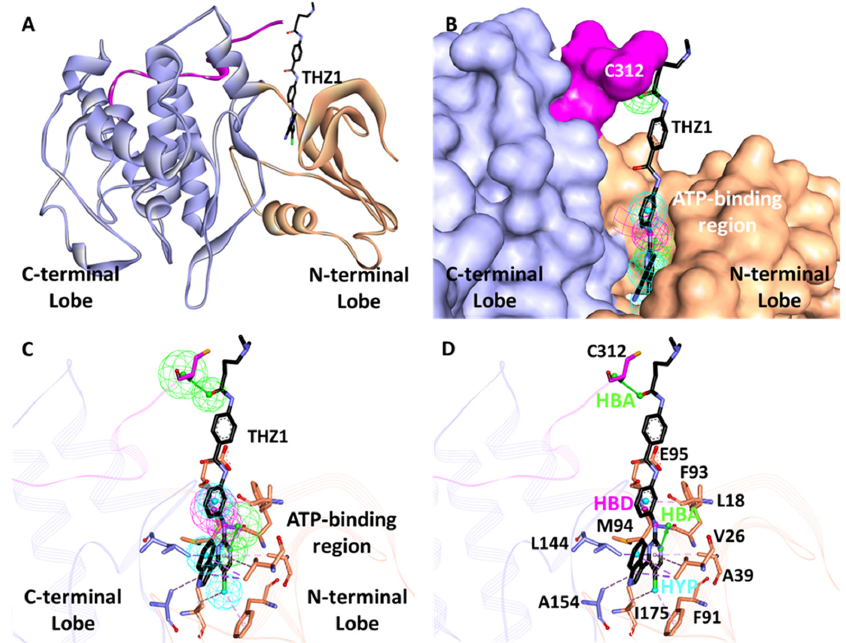
Figure 3. Generation of the structure-based pharmacophore. ( A ) CDK7 in complex with THZ1 was used to generate pharmacophore hypothesis. The N- and C-terminal of CDK7 are shown in tan and purple color, respectively. The region outside of the kinase domain is shown in pink. THZ1 is shown as a black stick. ( B ) The 3D representation of the pharmacophore inside the ATP-binding pocket of CDK7. ( C , D ) Mapping of pharmacophore hypothesis with the ATP-binding site residues and residue located outside the kinase domain Cys312 of CDK7. The surrounding residues are shown as sticks, and the hypothesis features are represented as hydrogen bond donor (HBD, magenta), hydrophobic (HYP, cyan), and hydrogen bond acceptor (HBA, green).